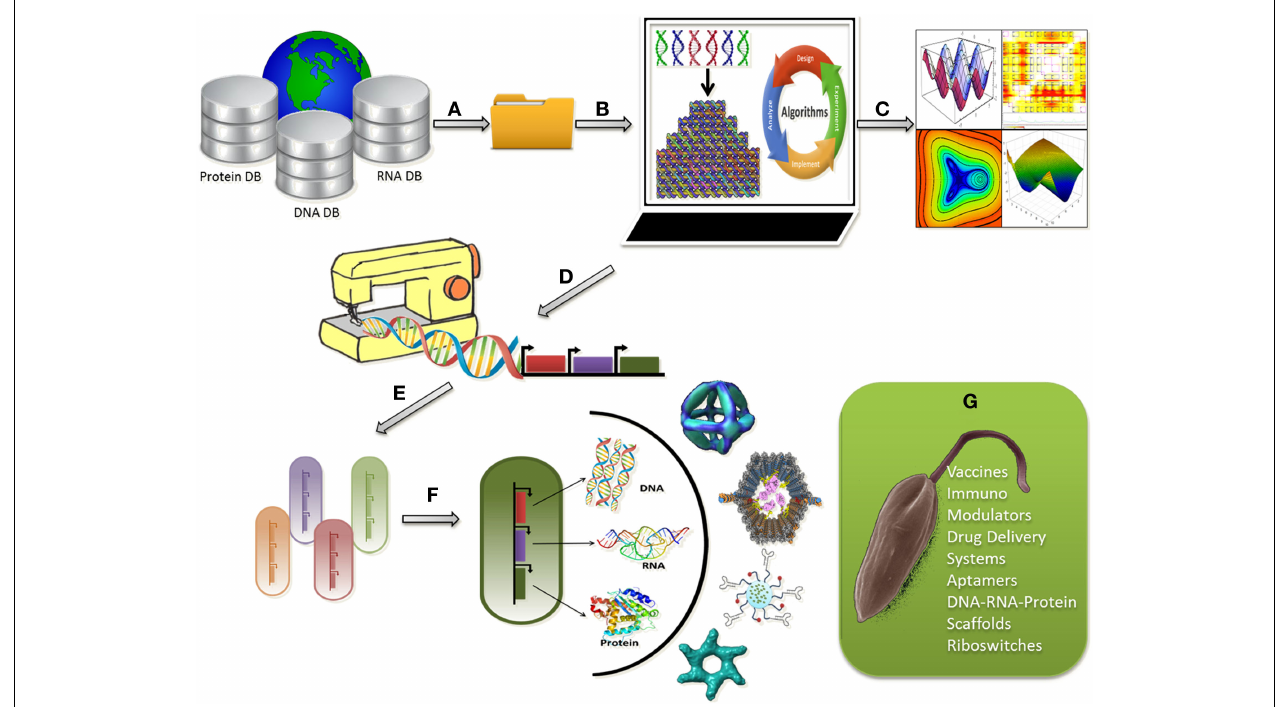
FIGURE 1 | Programmable synthetic constructs can be used to assemble nanostructures within living cells in a controlled fashion for leishmanicidal effects; (A) Raw sequence data of proteins, DNA, and RNA can be retrieved from databases; (B) Raw sequence data analysis for selection of a good sequence for nanostructure design followed by designing, modeling, simulation, and visualization of bionanosystems; (C) Computational analysis of